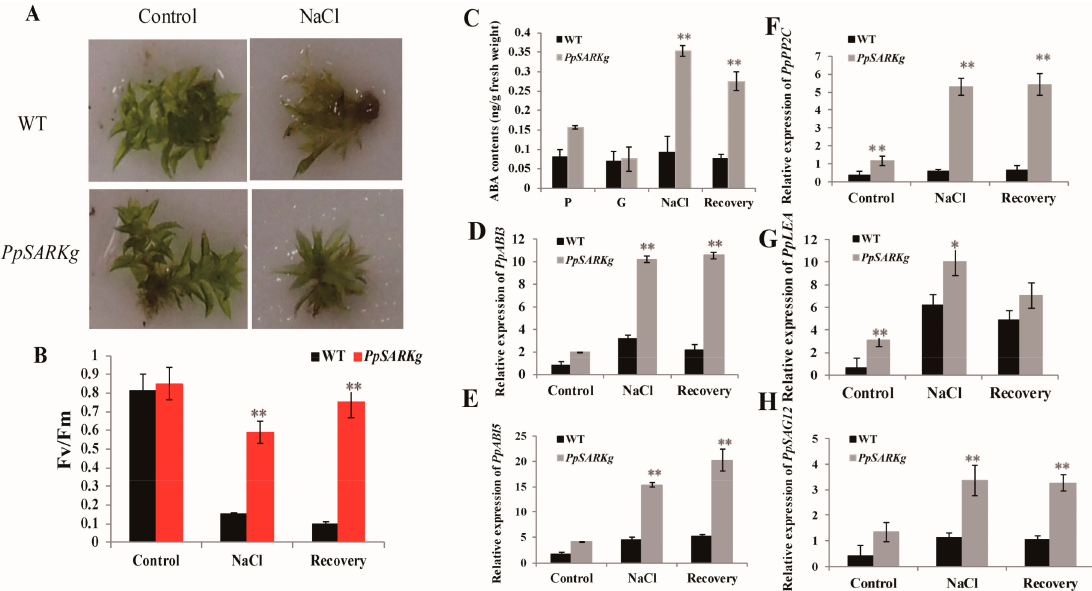
Figure 4. PpSARK regulates salt resistance and senescence via an ABA-related pathway. ( A ) PpSARKg plants were tolerant to salt stress. ( B ) Photosystem efficiency maintained during the salt treatment in gametophores of PpSARKg plants. Data are represented as means ± SD, n = 3. The t -test was used and an asterisk indicates that the value of treatment is different from the control (WT); ** p < 0.01. ( C ) Endogenous ABA contents of PpSARKg plants; three biological replicates with at least three technical repeats were done. P—protonema tissue at five days old; G—gametophyte at one month old. ( D – H ) The expression of marker genes in the ABA signaling pathway and senescence were induced in salt stress treatment. Data are represented as means ± SD, n = 3. The t -test was used and an asterisk indicates that the value of treatment is different from the control (WT); * p < 0.05; ** p <